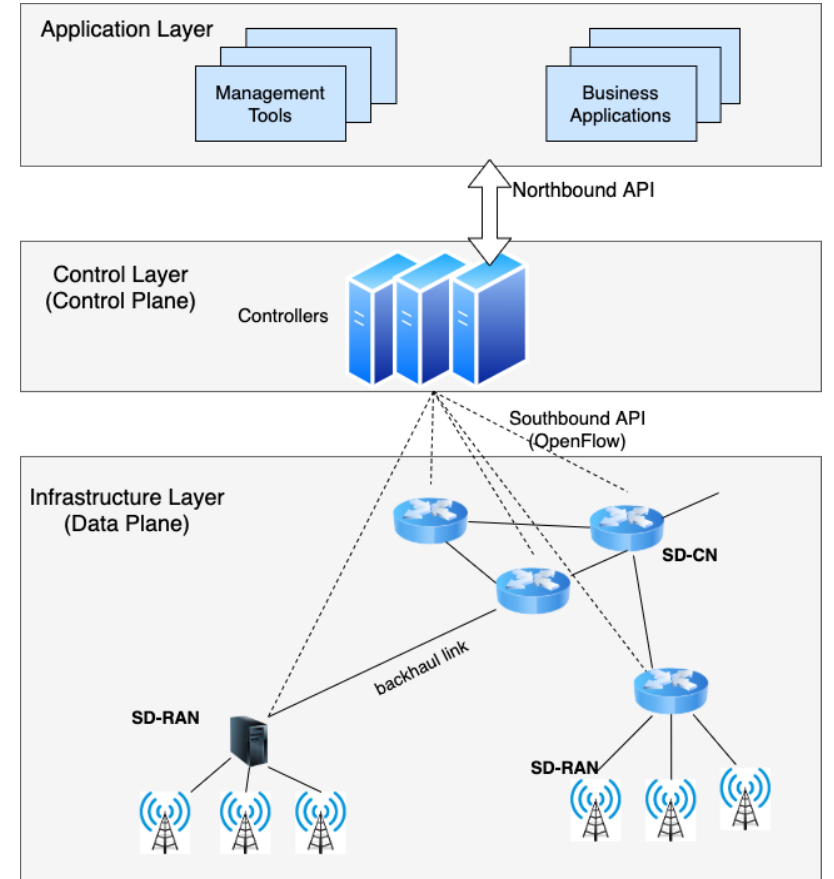
Figure 3. Software-Defined 5G Network